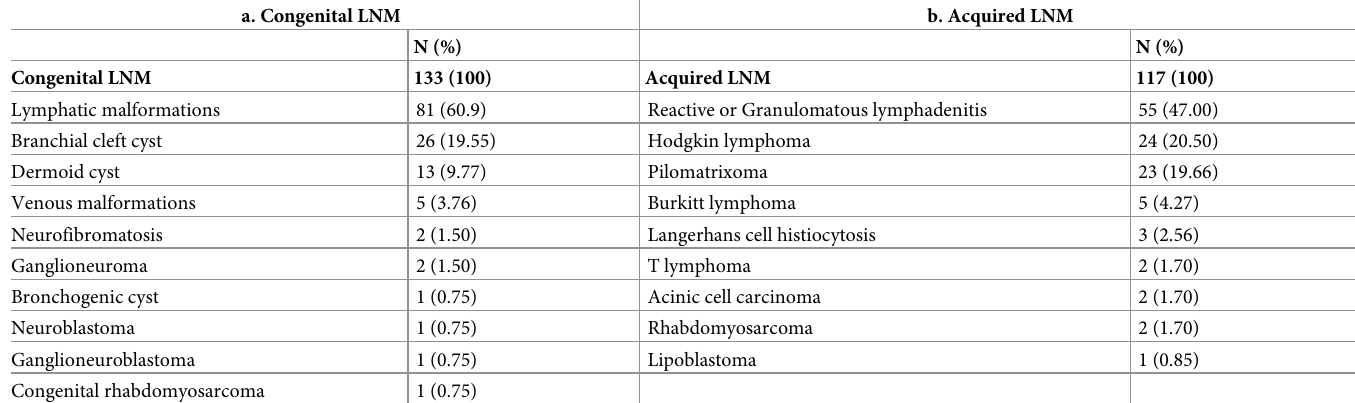
Table 2. Findings of histopathology and citology examinations in pediatric patients with lateral neck